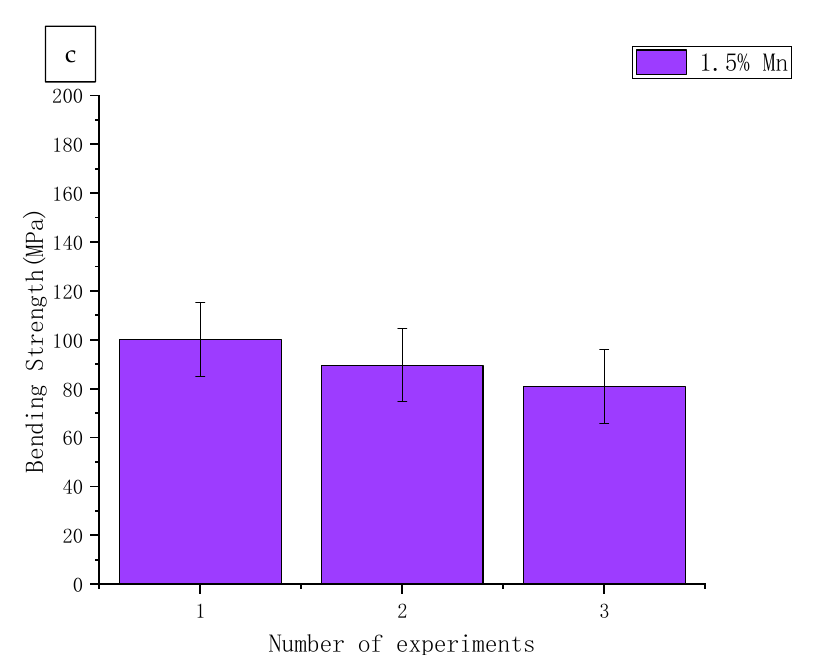
Figure 7. Maximum bending strength of the specimen . ( a ) 0.5 % Mn; ( b ) 1.0 % Mn; ( c ) 1.5 % Mn.